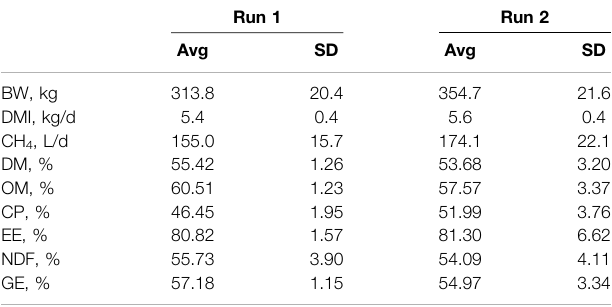
TABLE 1 | Body weight, dry matter intake, CH 4 emission and nutrient